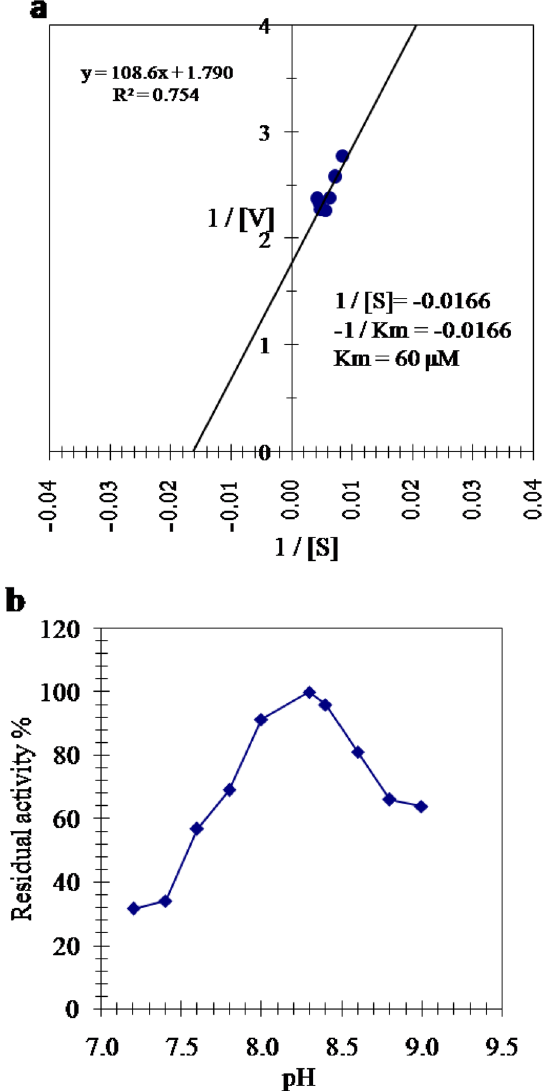
Fig. 3 a Lineweaver–Burk plot relating the reciprocal of the reaction velocity of the purified camel thrombin to the reciprocal of the substrate concentration in μ Μ (1/[S]) by using N-p-Tosyl-Gly-Pro- Arg-p-nitroanilide acetate as substrate. The reaction velocity is the change in absorbance at 405 nm per 30 min. b Effect of pH on the camel thrombin activity using N-p-Tosyl-Gly-Pro-Arg-p-nitroanilide acetate as a substrate in 0.05 M Tris–HCl buffer of various pH values